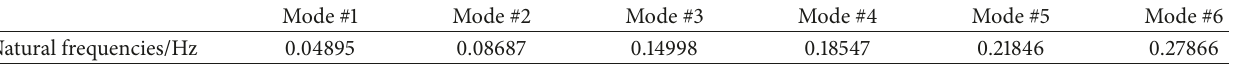
Table 3: First six-order natural frequencies.